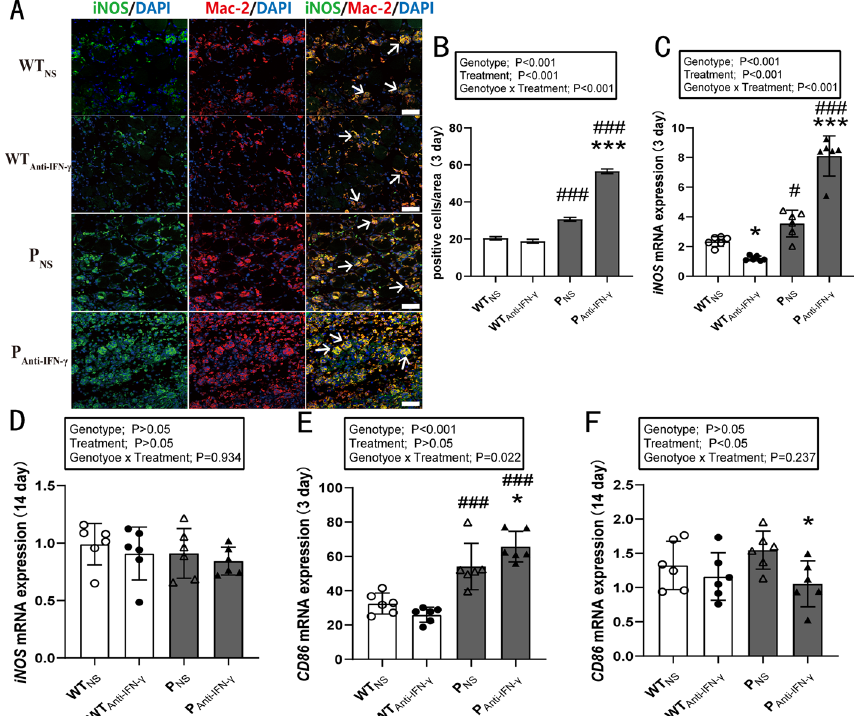
Fig. 4 IFN-γ blockade after PD-1 knockout increases proinflammatory macrophage activation in injured skeletal muscle. WT NS : wild-type injured group with normal saline injection, WT Anti-IFN-γ : wild-type injured group with Anti-IFN-γ antibody injection, P NS : PD-1 − / − injured group with normal saline injection, P Anti-IFN-γ : PD-1 − / − injured group with Anti-IFN-γ antibody injection. A Representative double immunofluorescence staining of iNOS and Mac-2 at 3 days post injury, B quantification of pro-inflammatory macrophages per field as in A , C iNOS mRNA expression at 3 days post injury, D iNOS mRNA expression at 14 days post injury, E CD86 mRNA expression at 3 days post injury, F CD86 mRNA expression at 14 days post injury. * P < 0.05, *** P < 0.001, different from NS treatment when comparing the same genotype. # P < 0.05, ### P < 0.001, different from WT mice when comparing the same treatment. Data are shown as mean standard deviation (SD), ± n 3 ( B ), n 6 ( C – F ). White scale bar, 50 μm. Proinflammatory = = →